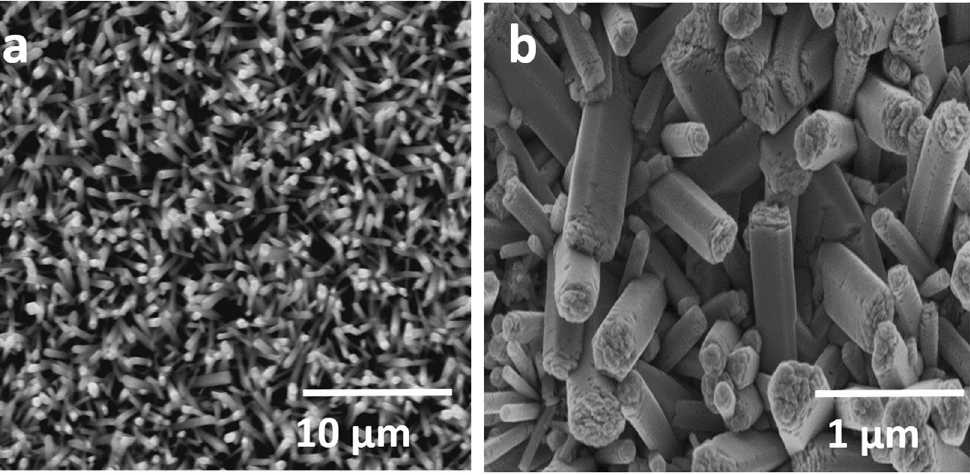
Figure 1. SEM top-view of solution grown ZnO NR arrays ( a ) at low magnification and ( b ) at high